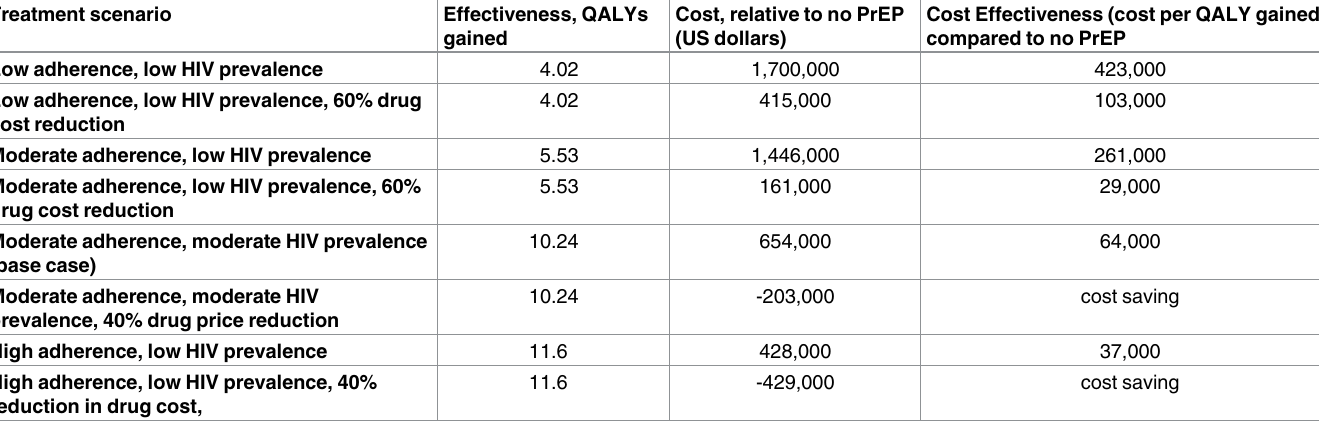
Table 2. Accumulated quality-adjusted life yearsgained, cost, and cost-effectiveness of selected